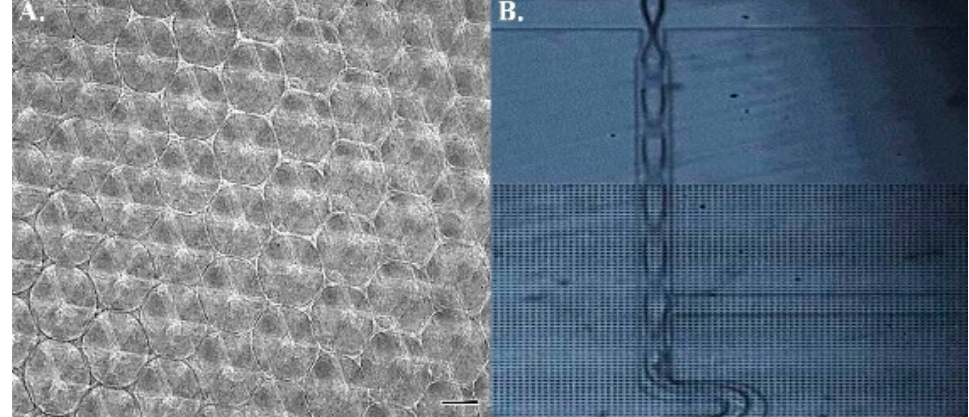
Figure 1. Fabrication of 3D polyacrylamide scaffold. ( A ) The diameter of each sphere was set at 100 μ m. ( B ) The microfluidic device was employed to carry nitrogen for polyacrylamide and ammonium persulfate mixing. Scale bar = 100 μ m.